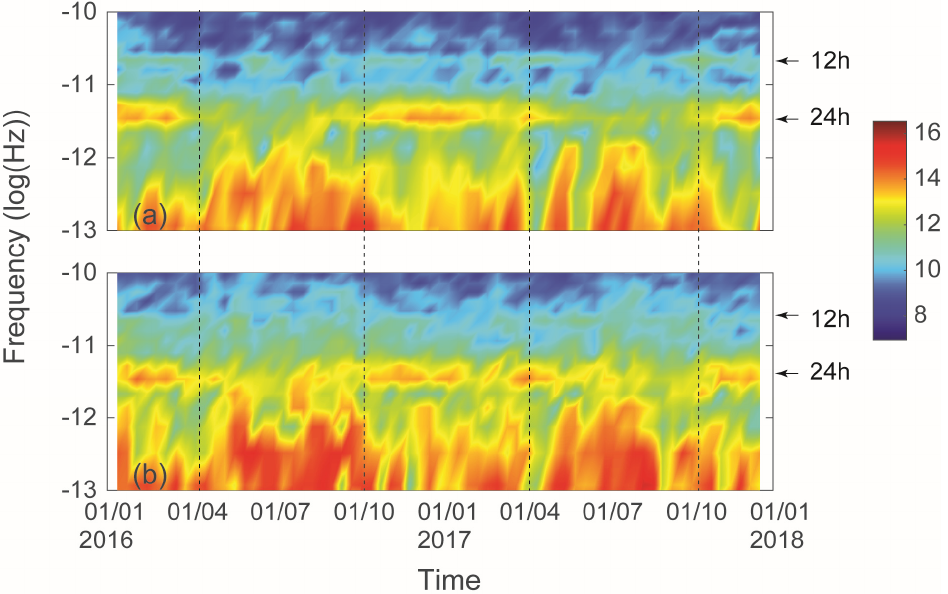
Figure 4. Time frequency plot of spectral energy calculated from the wind time series at Rottnest Island station for the period 2016-2017. ( a ) east-west component; and, ( b ) north-south component. Units of spectral energy are log[m 2 s − 2 /Hz].